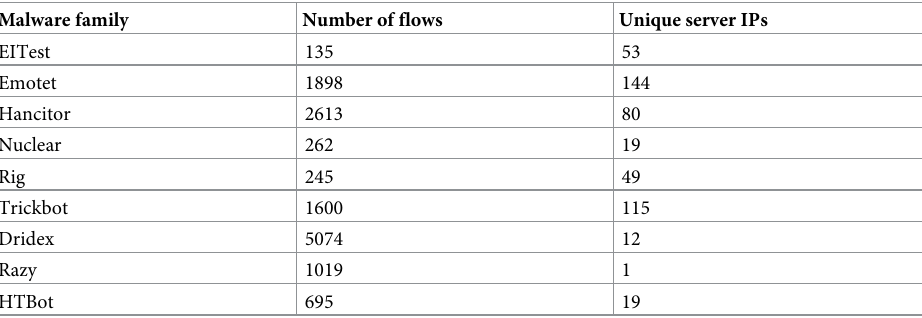
Table 3. TLS flows in each malware